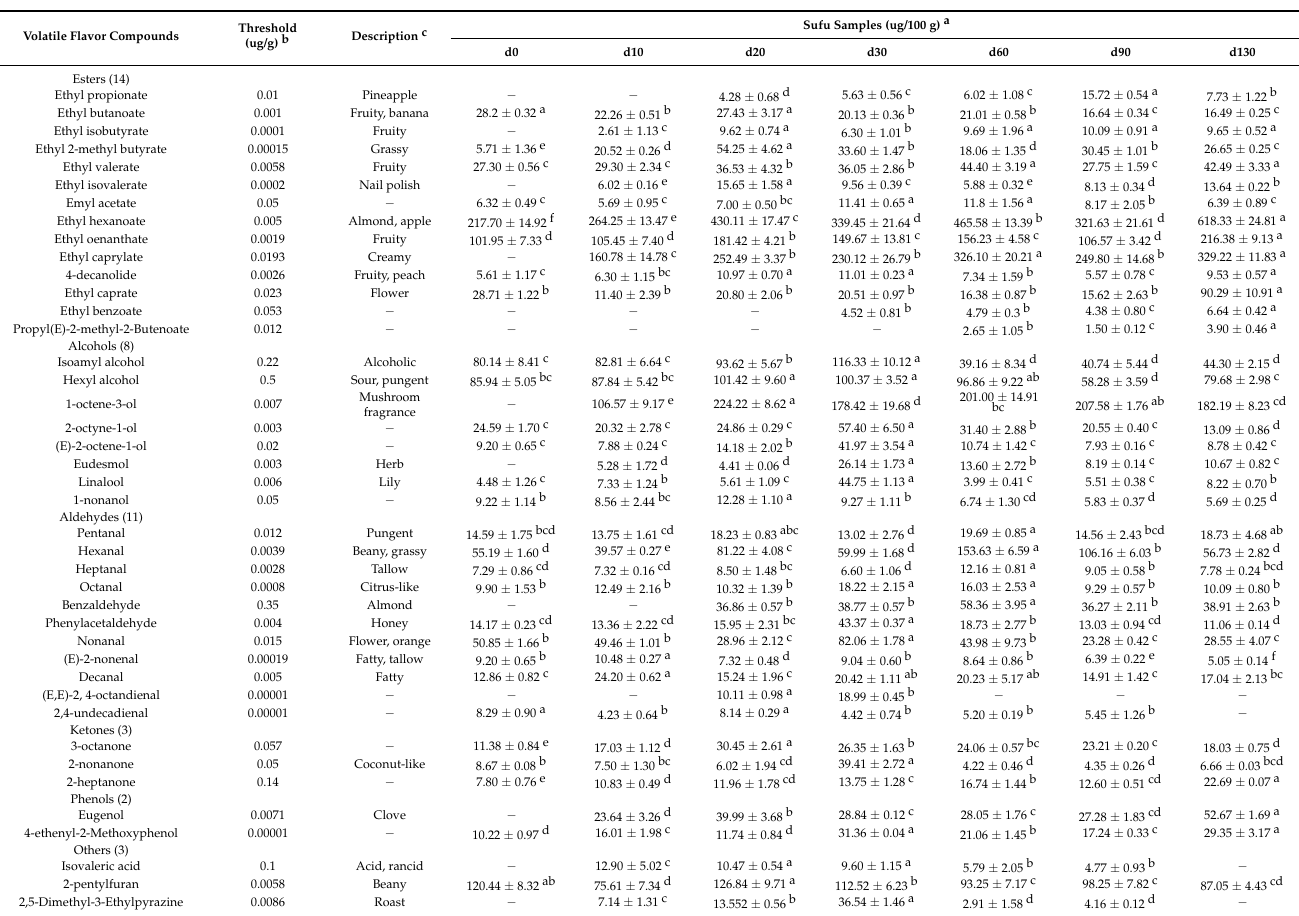
Table 1. Characteristic volatile flavor compounds of sufu